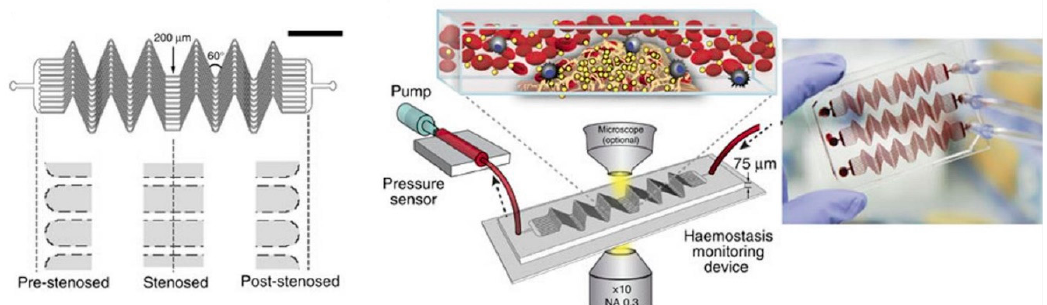
Figure 4. A biomimetic microfluidic device with angular bends designed to represent different shear rates at the diseased regions of the vascular system including a diagram of the device showing the stenosed, pre-stenosed and post-stenosed regions of the microchannel, a schematic of the haemostasis monitor and device and a photograph of three devices in a PDMS mold on a glass substrate. Taken with permission from [39].